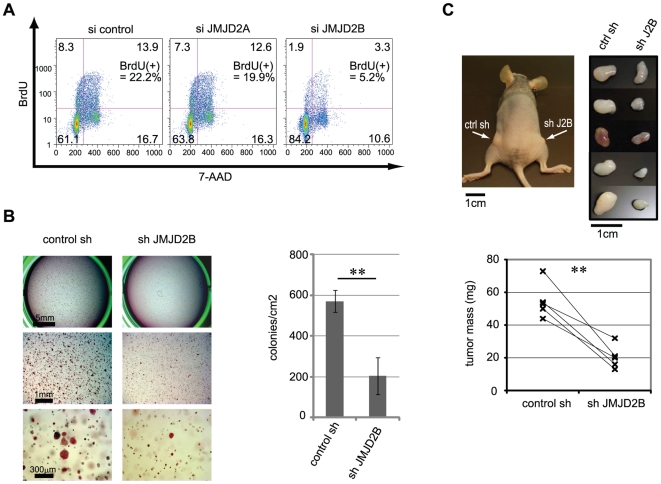
JMJD2B positively regulates the proliferation of ER-positive breast cancer cells.(A) JMJD2B knockdown impairs proliferation. T-47D cells were transfected with either control siRNA or siRNA against JMJD2A or JMJD2B, cultured for 72 hr, pulsed for 1 hr with BrdU, stained with APC-conjugated anti-BrdU antibody and 7-AAD, and analyzed by flow cytometry. Results are representative of four independent trials. (B) JMJD2B knockdown impairs colony formation. Single cell suspensions of ZR-75-1 cells expressing control shRNA or shRNA against JMJD2B were seeded in soft agar. After 14 days, colonies were stained with crystal violet and microscopic fields were photographed (left). The number of colonies/cm2 was determined (right). Data represent the colony density of three wells (mean ± s.d). **p<0.01. Representative data of three independent trials. See also Figure S2. (C) JMJD2B knockdown impairs tumor formation in xenograft model. Upper left: tumors (indicated by arrows) in a representative NIH-III mouse injected with control ZR-75-1 cells on the left flank and JMJD2B-depleted ZR-75-1 cells on the right flank. Upper right: dissected tumors from nude mice. Lower: mass of tumors is shown. **p<0.01.